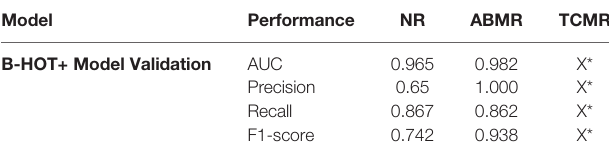
*Insuf fi cient sample size. ABMR, Antibody-Mediated Rejection; AUC, Area under the ROC curve; B-HOT, Banff- Human Organ Transplant; NR, Non-Rejection; TCMR, T-Cell-Mediated